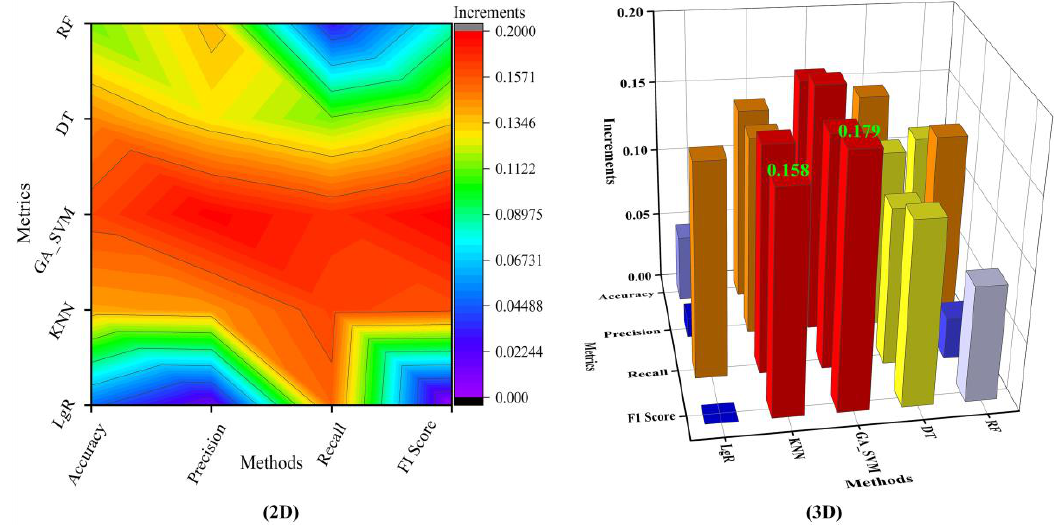
Figure 14. The increments of different algorithm metrics after use of data augmentation.